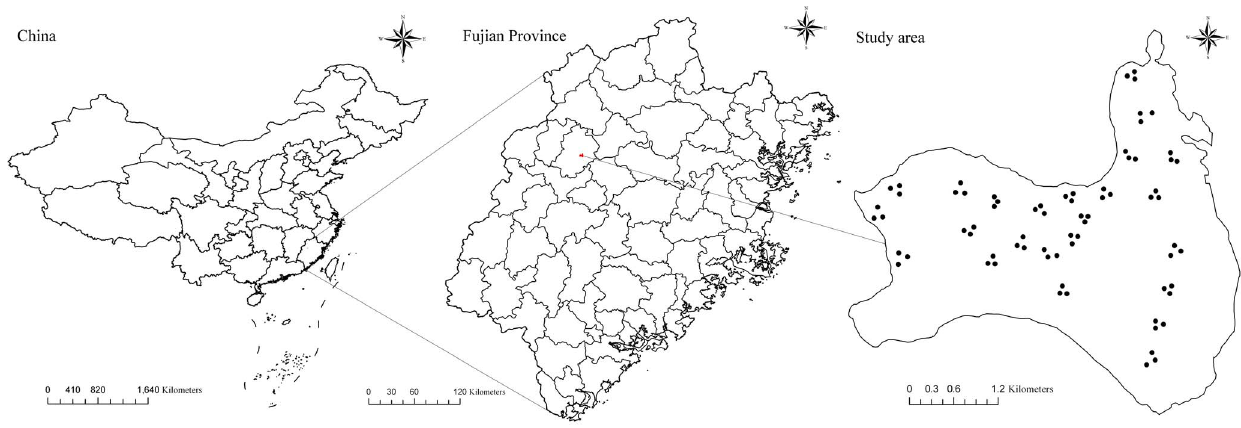
Figure 1. Seventy two trees in twenty four sample plots on Jiangle state-owned forest farm in southeast China.